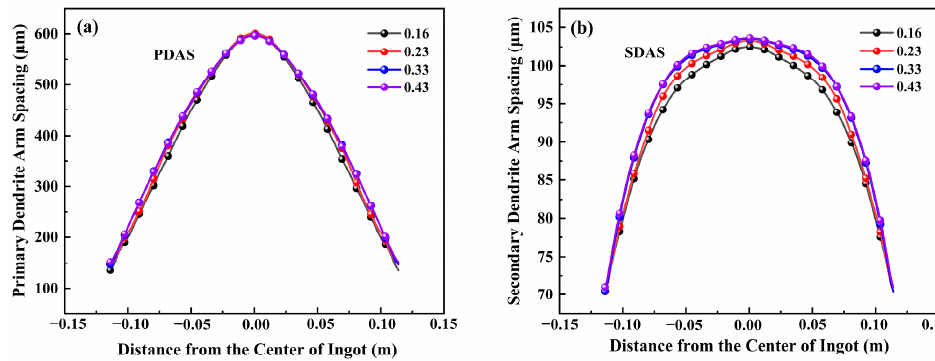
Figure 14. Change of PDAS ( a ) and SDAS ( b ) along radical direction with varying filling ratio.